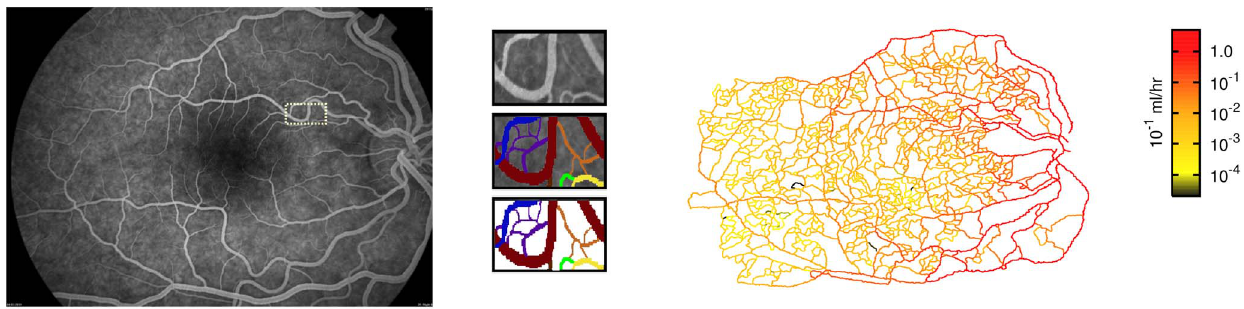
Figure 1. Characterization of the vascular network. Left panel: The original angiography of the retina that was digitalized. Identified with a small rectangle is the area that is amplified in the central panel. Center panel: Zoom of detail in angiography: original detail (top); manual identification of vessels with different colors indicating joined vessels of similar caliber (center); geometry that is digitalized to obtain the reconstructed network (bottom). Right panel: The blood flow in the reconstructed network. The color gradient indicates the flow intensity.